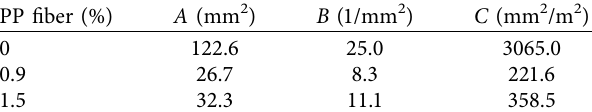
Table 6: Effect of PP fiber on the cracking of CGA mortar.